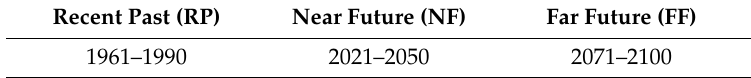
Table 1. The time windows used for simulations in the Climate for Culture